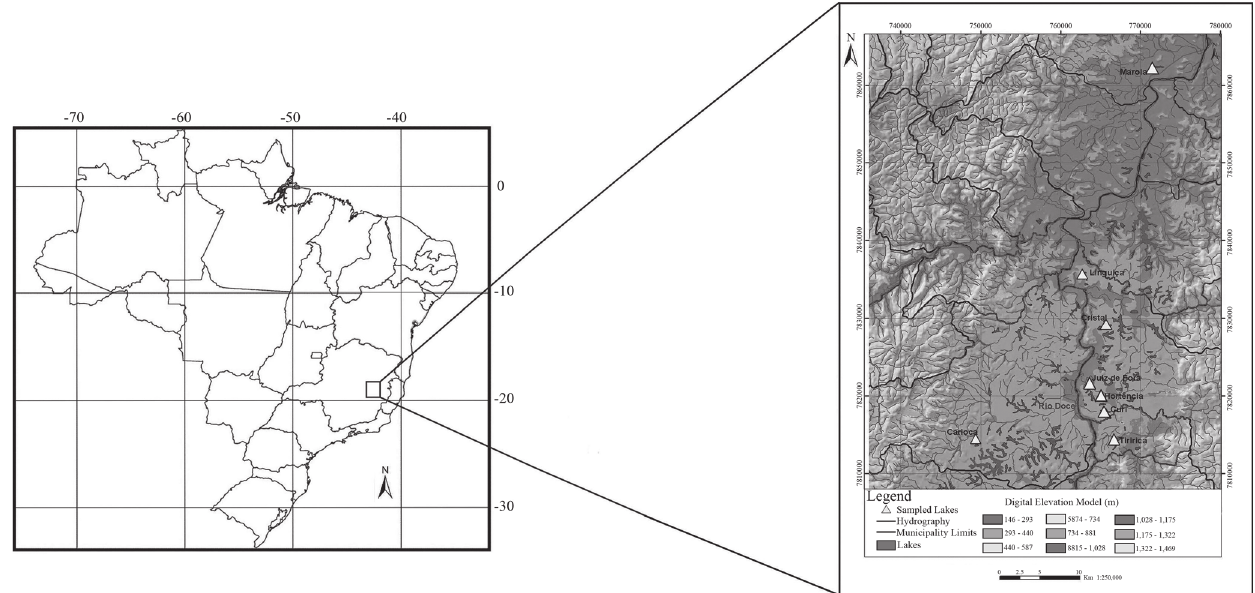
Fig. 1. Lacustrine system of the middle rio Doce. Triangles indicate sampled lakes.